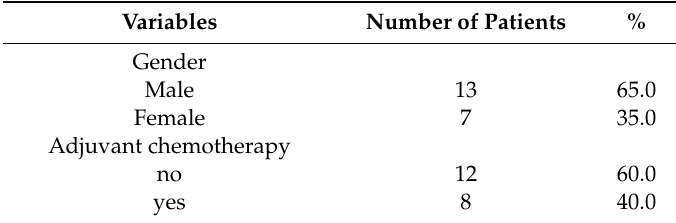
Table 2. Characteristics of 20 patients with pulmonary metastases of colorectal carcinoma.